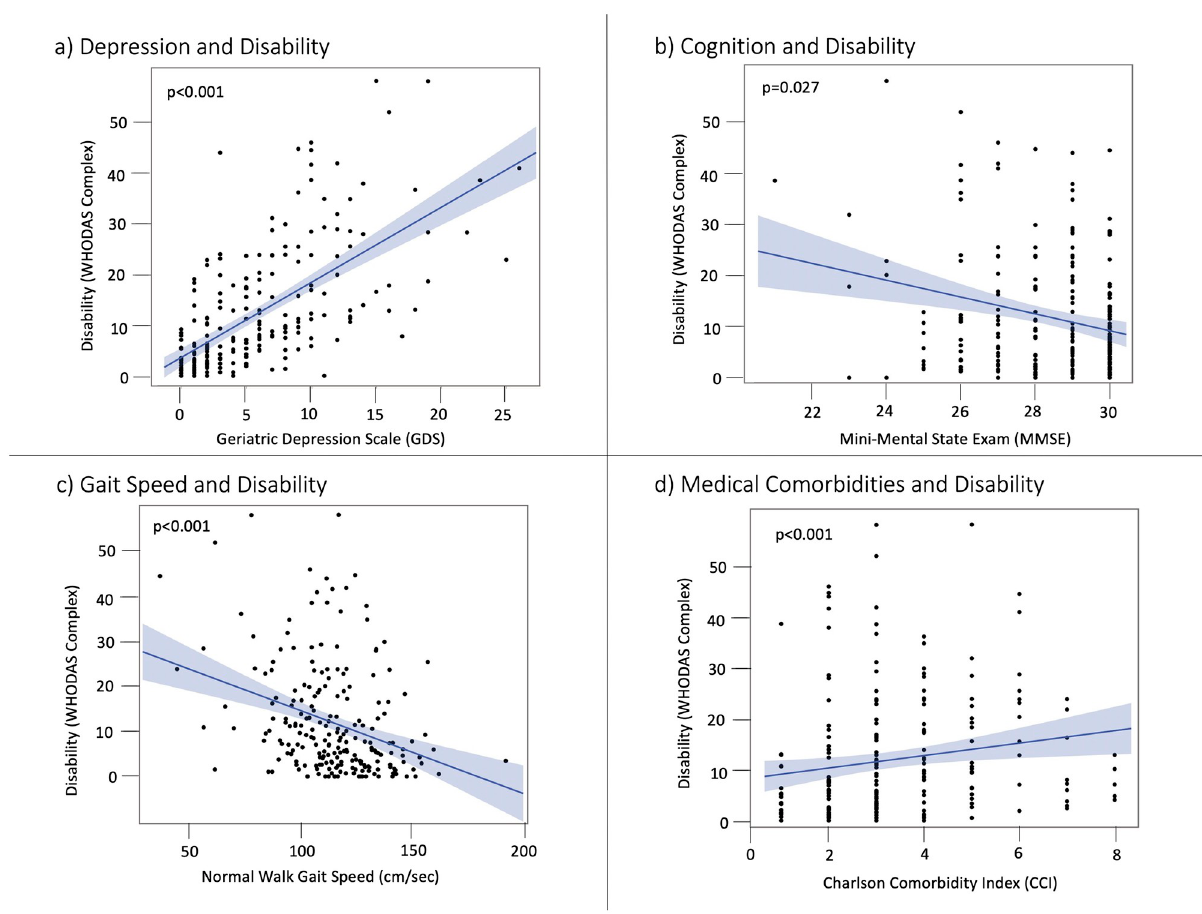
Fig 2. Association between cognition, gait and comorbidities and disability at baseline. a: Greater disability on the World Health Organization Disability Assessment Schedule 2.0 (WHODAS) was associated with higher depression scores on the Geriatric Depression Scale (GDS, p < 0.001). b: More disability was associated with worse cognition on Mini-Mental State Examination (MMSE, p = 0.027). c: More disability was associated with slower gait speed during normal walk (NW, p < 0.001). d: More disability was associated with medical comorbidities on the Charlson Comorbidity Index total points (CCI, p <